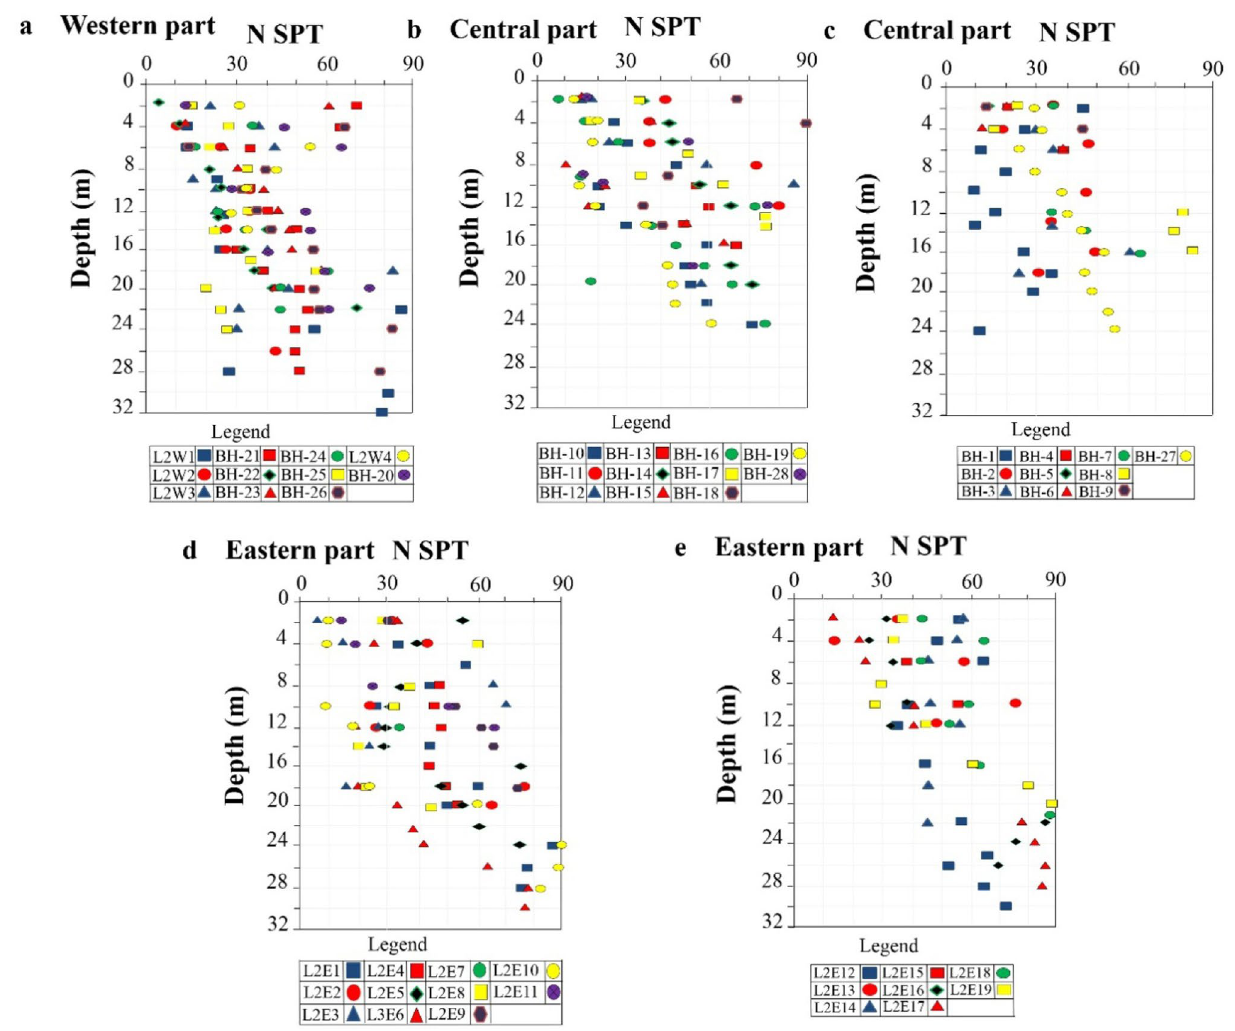
Fig. 8 Variation of SPT-N with depth along the TML2: a Western, b , c Central and d , e Eastern parts (Authors)